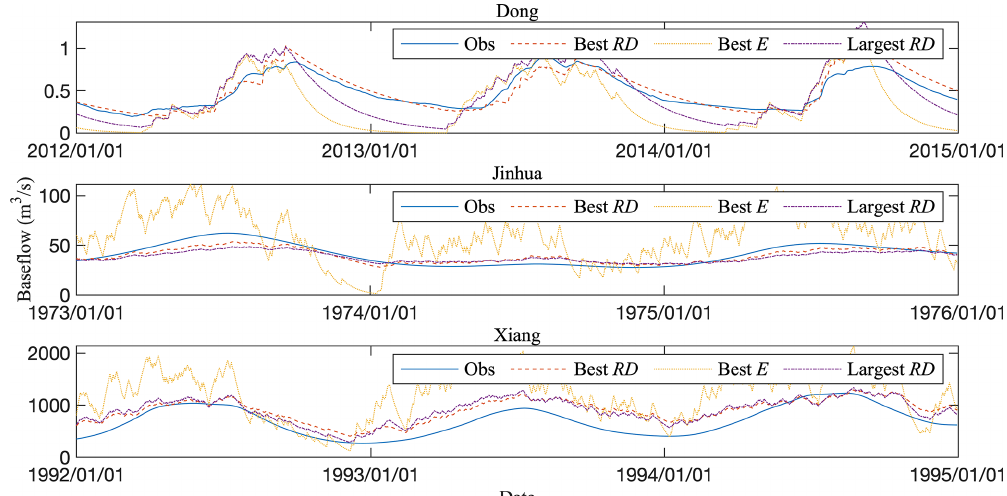
Figure 15. Baseflow in typical models and observations (representative 3 year hydrographs are